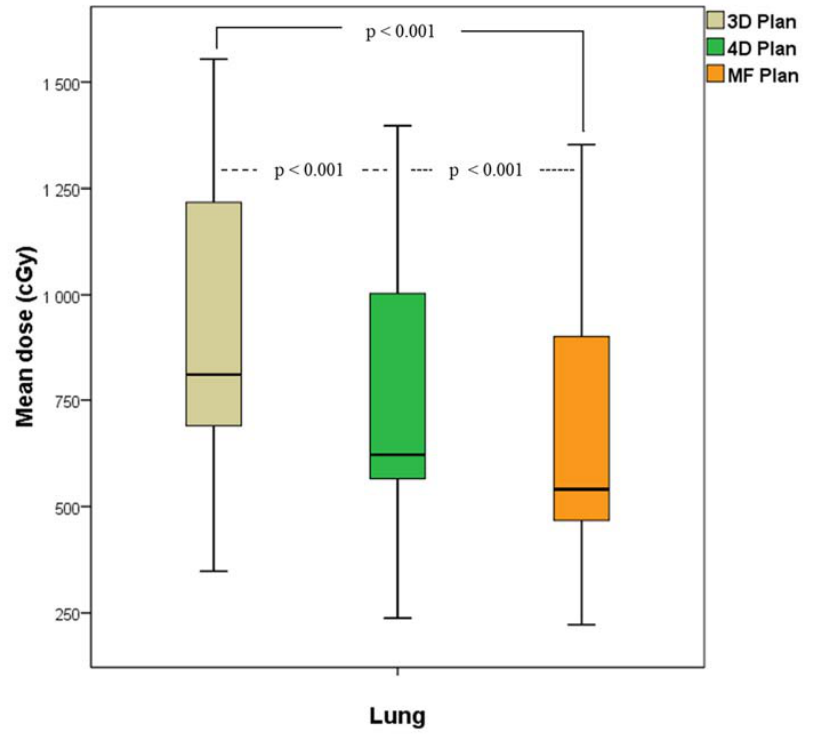
Figure 5. Box plot of the mean radiation dose received by the lung in the three treatment plans.